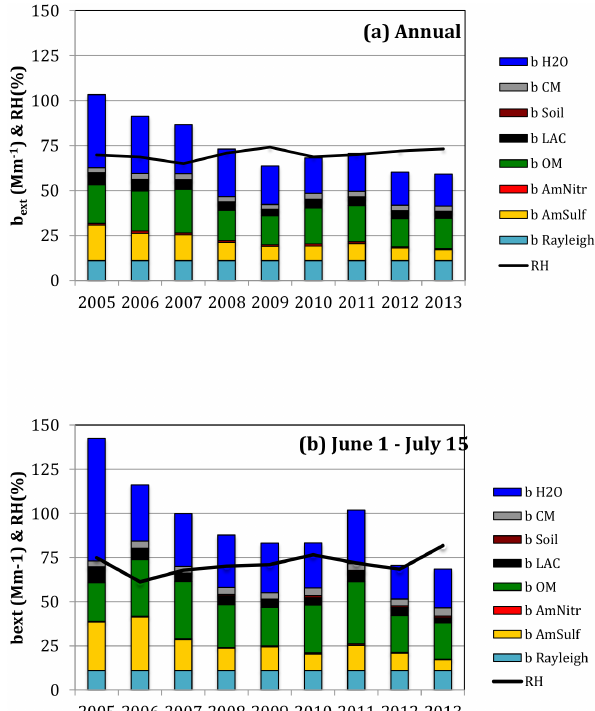
Figure 11. Mean annual light extinction computed from daily species concentrations at CTR calculated using the new IMPROVE algorithm (a) . Mean light extinction computed from daily species concentrations at CTR during 1 June–15 July of each year (b) . The aerosol components include ammonium salts, OM ( = 1.8OC), light- absorbing carbon (LAC), soil dust, coarse material (CM), and water. The black line shows the measured RH averaged over different peri- ods represented in the two panels of the figure. RH dependence was computed using the new IMPROVE f(RH) formula with hourly RH measurements at each site. Effects of water in particles, associated with SO 4 and NO 3 , are shown separately as the b H 2 O term (See also Fig.